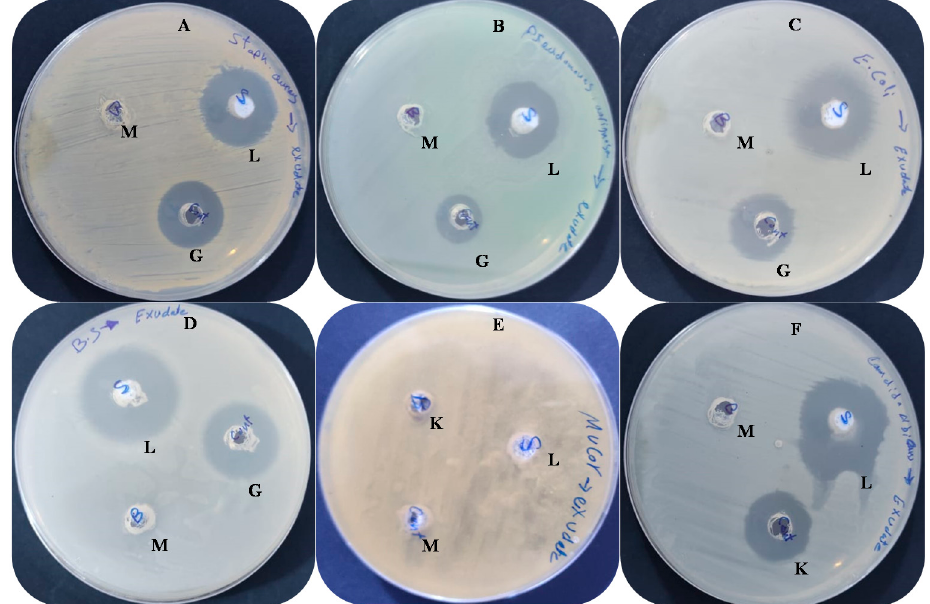
Figure 3. Antimicrobial activities against S. aureus ( A ), P. aeruginosa ( B ) , E. coli ( C ) , B. subtilis ( D ), M. circinelloides ( E ), and C. albicans ( F ); where antimicrobial activity represented by latex (L), methanolic (M), Gentamycin (G), Ketoconazole (K).